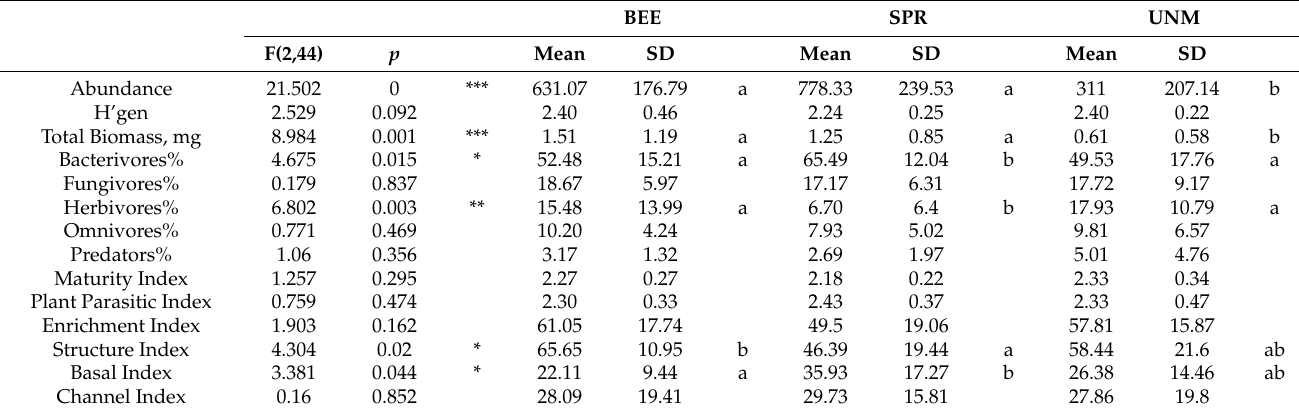
Table 3. The one-way ANOVA results (F and p -values with significance level) among three forest types: BEE—European beech Fagus sylvatica L.; SPR—Norway spruce Picea abies (L.) H. Karst.; UNM—unmanaged old-growth forest, in 2019 in Pol’ana Mts. Means and standard deviation (SD) of nematode abundance, genera diversity index, H’gen, abundance of nematodes in trophic groups—ecological and functional indices. Soil sampling in 2019 in Pol’ana Mts., Slovak Republic.